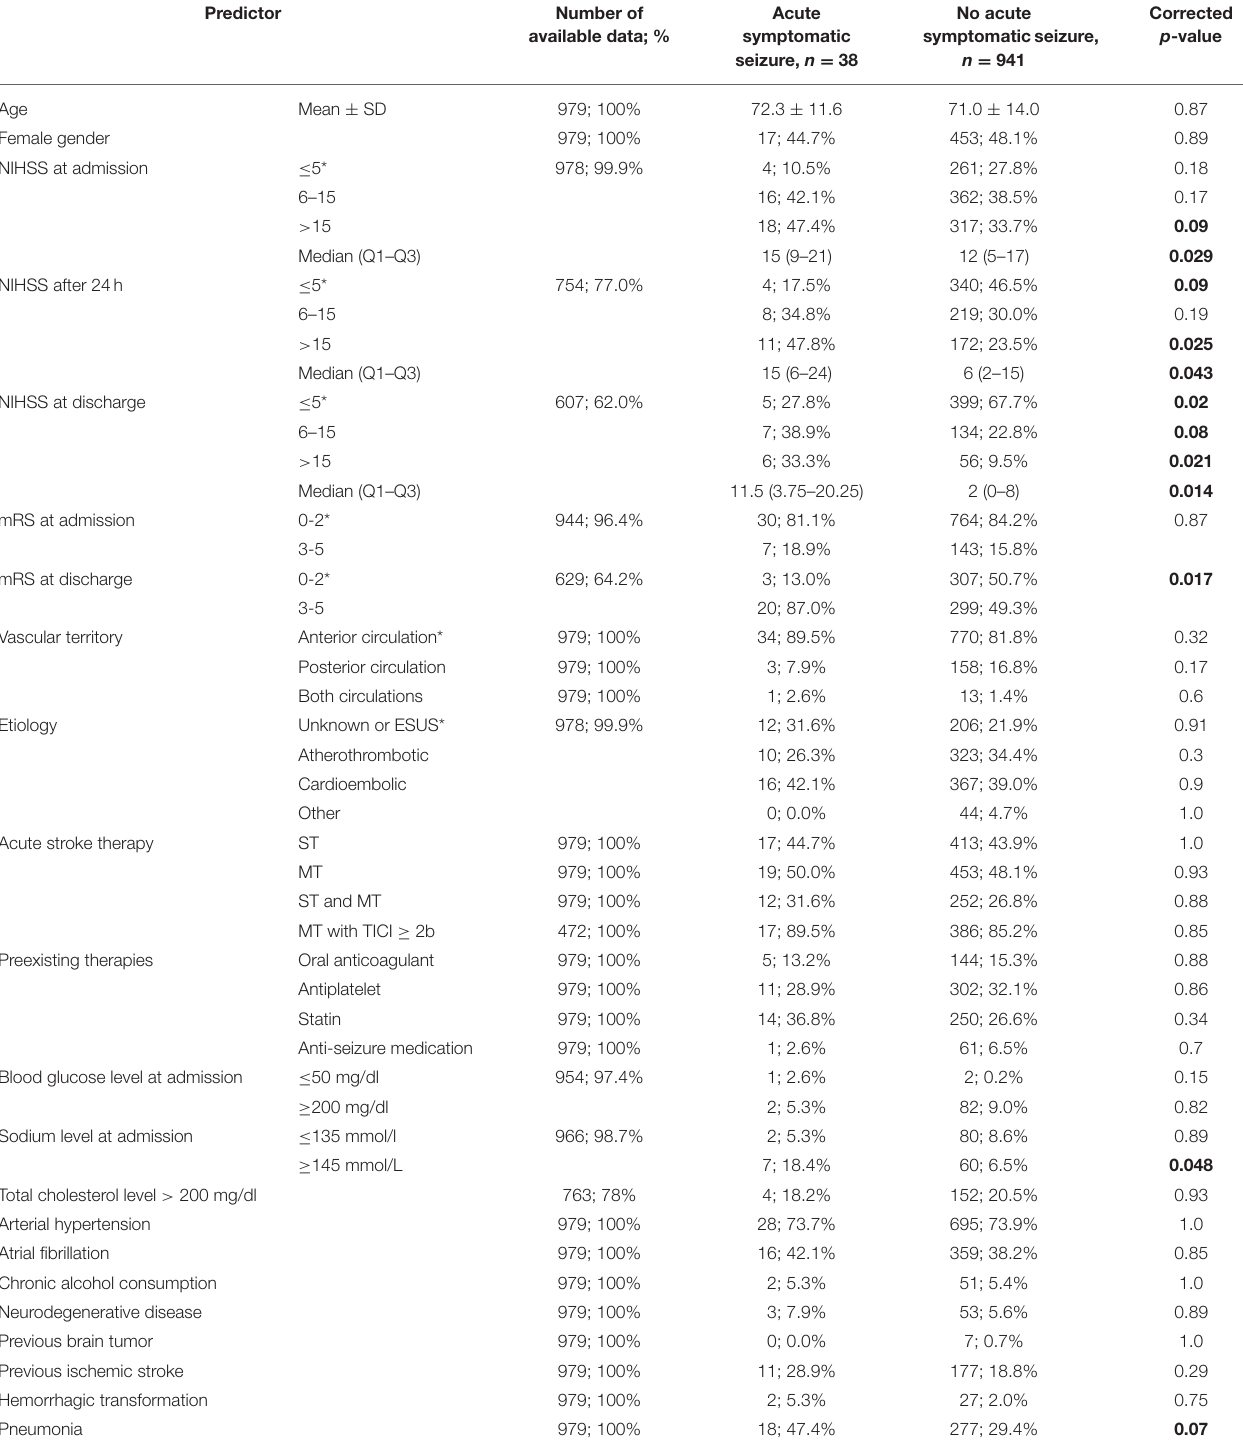
TABLE 1 | Univariate logistic regression analysis of clinical parameters and their association with acute symptomatic seizures in patients after ischemic stroke. Predictor Number of